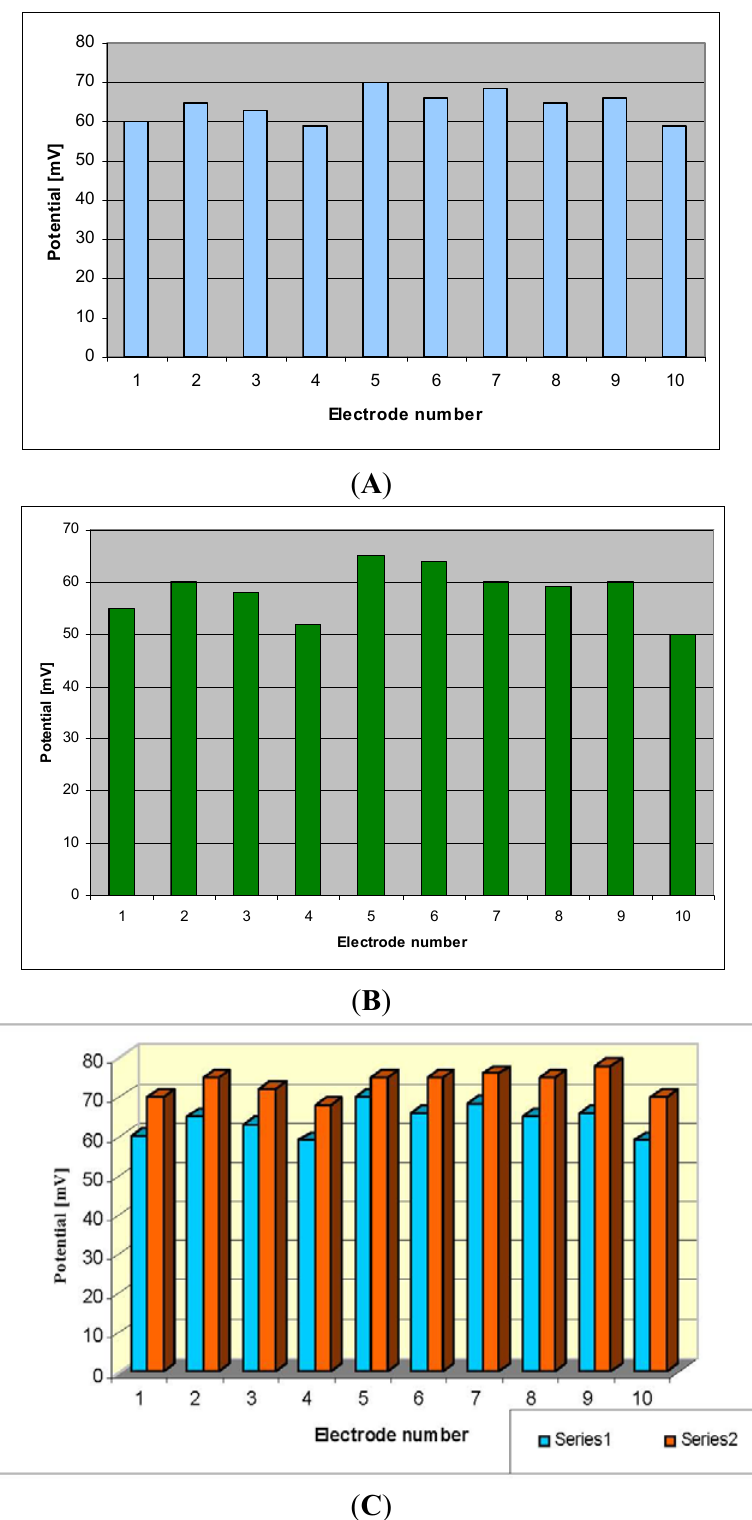
Figure 10. Potential measurement of HaCaT cell culture by using ten ( A ) Pt electrodes on silicon; ( B ) laser nanostructured Pt electrodes on silicon; ( C ) Pt electrode on silicon after 24 h of